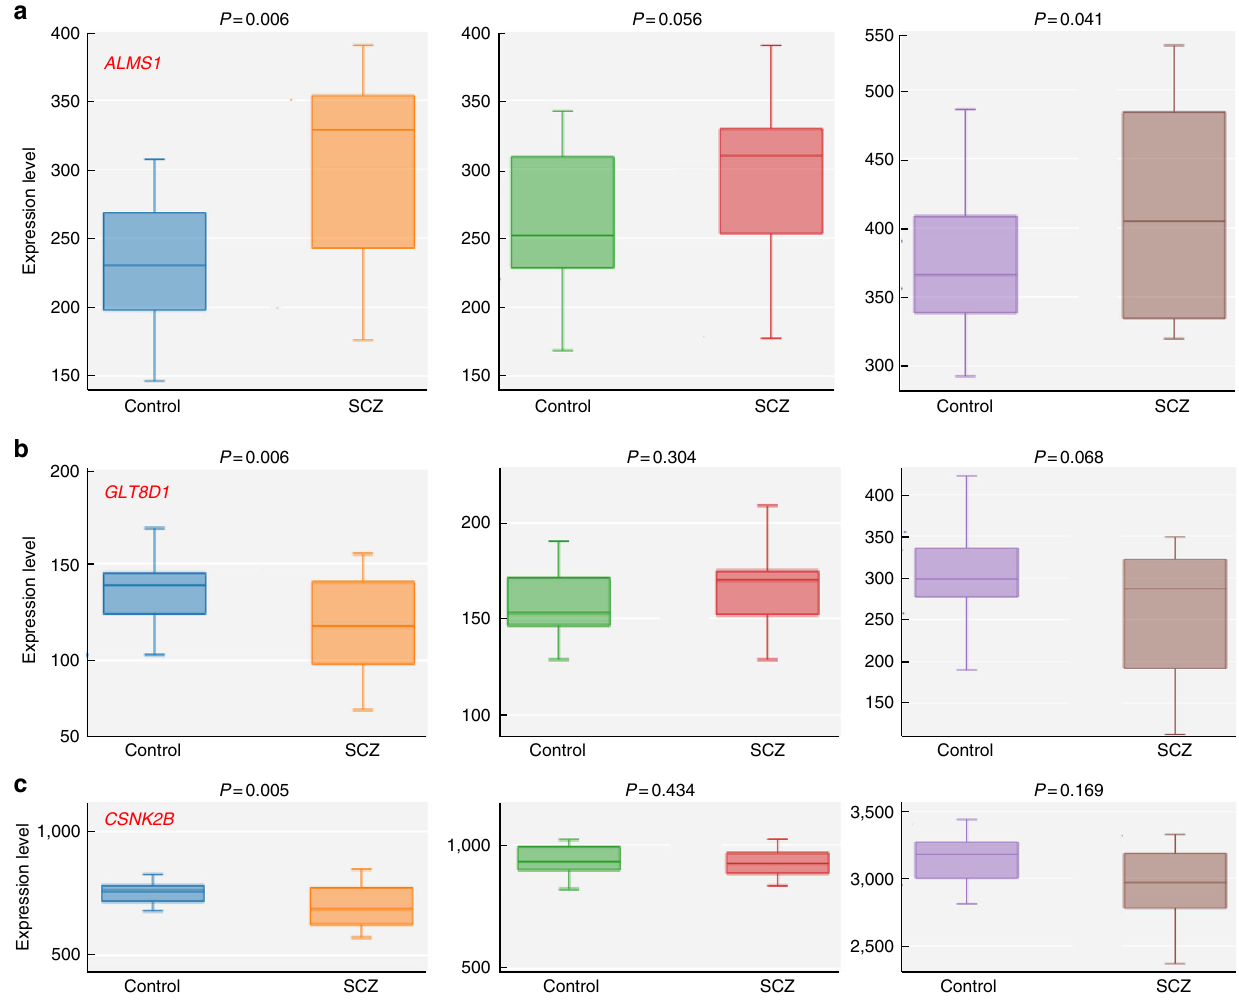
Fig. 2 Dysregulation of ALMS1 , GLT8D1 , and CSNK2B in schizophrenia cases vs. healthy controls. a mRNA expression of AMLS1 is signi fi cantly upregulated in the hippocampus and striatum ( P = 0.006 and 0.041, respectively) of schizophrenia cases (SCZ) compared with healthy subjects (Control) (GSE53987 expression data set 40 , 19 schizophrenia cases, and 19 controls). In the prefrontal cortex, AMLS1 also showed a trend of up-regulation ( P = 0.056). b , c Expression of GLT8D1 and CSNK2B is signi fi cantly decreased in the hippocampus of schizophrenia cases compared with controls. Left panel, hippocampus, middle panel, prefrontal cortex, right panel, and striatum. Student ’ s t -test was used to compare whether the expression of ALMS1 , GLT8D1 , and CSNK2B was signi fi cantly different in schizophrenia cases ( n = 19) and controls ( n =